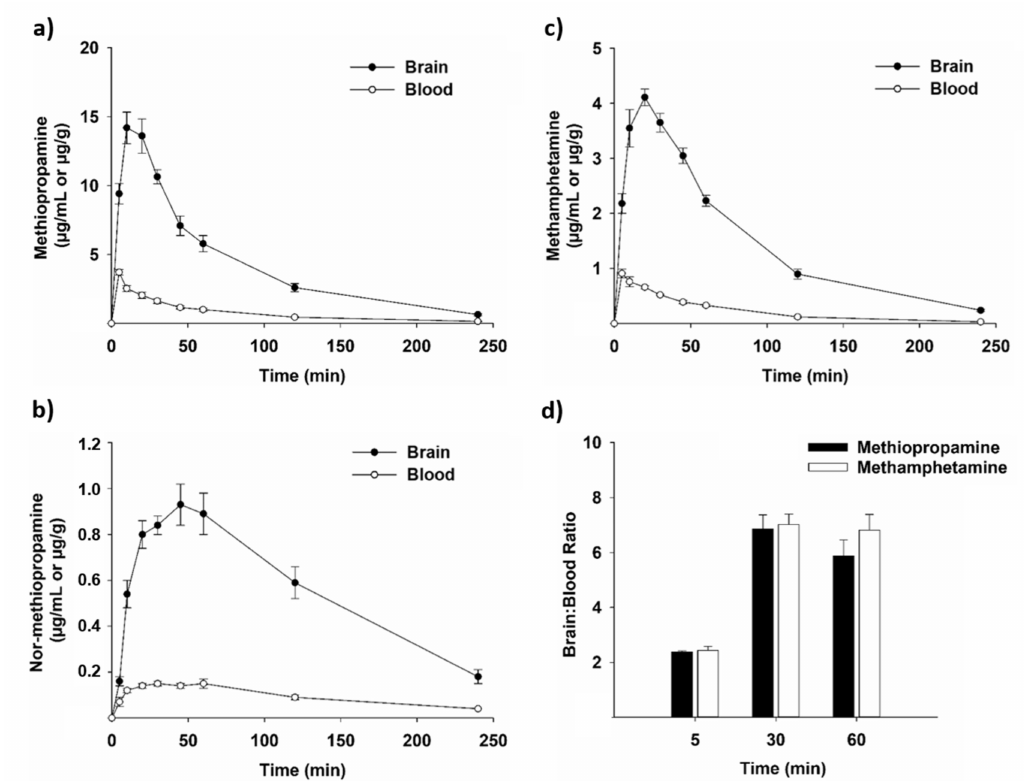
Figure 3. Concentrations of ( a ) methiopropamine, ( b ) nor-methiopropamine and ( c ) methamphetamine in mouse blood (white dots) and brain tissue (black dots) 5, 10, 20, 30, 45, 60, 120 and 240 min after a single i.p. injection of 12.5 mg/kg methio- propamine ( a , b ) or 3.75 mg/kg methamphetamine ( c ). Each time point represents mean ± SEM of blood ( µ g/mL) or brain ( µ g/g) concentrations, n = 4–8. ( d ) The concentration ratio in brain vs. blood for methiopropamine and methamphetamine 5, 30 and 60 min after drug injection, n =